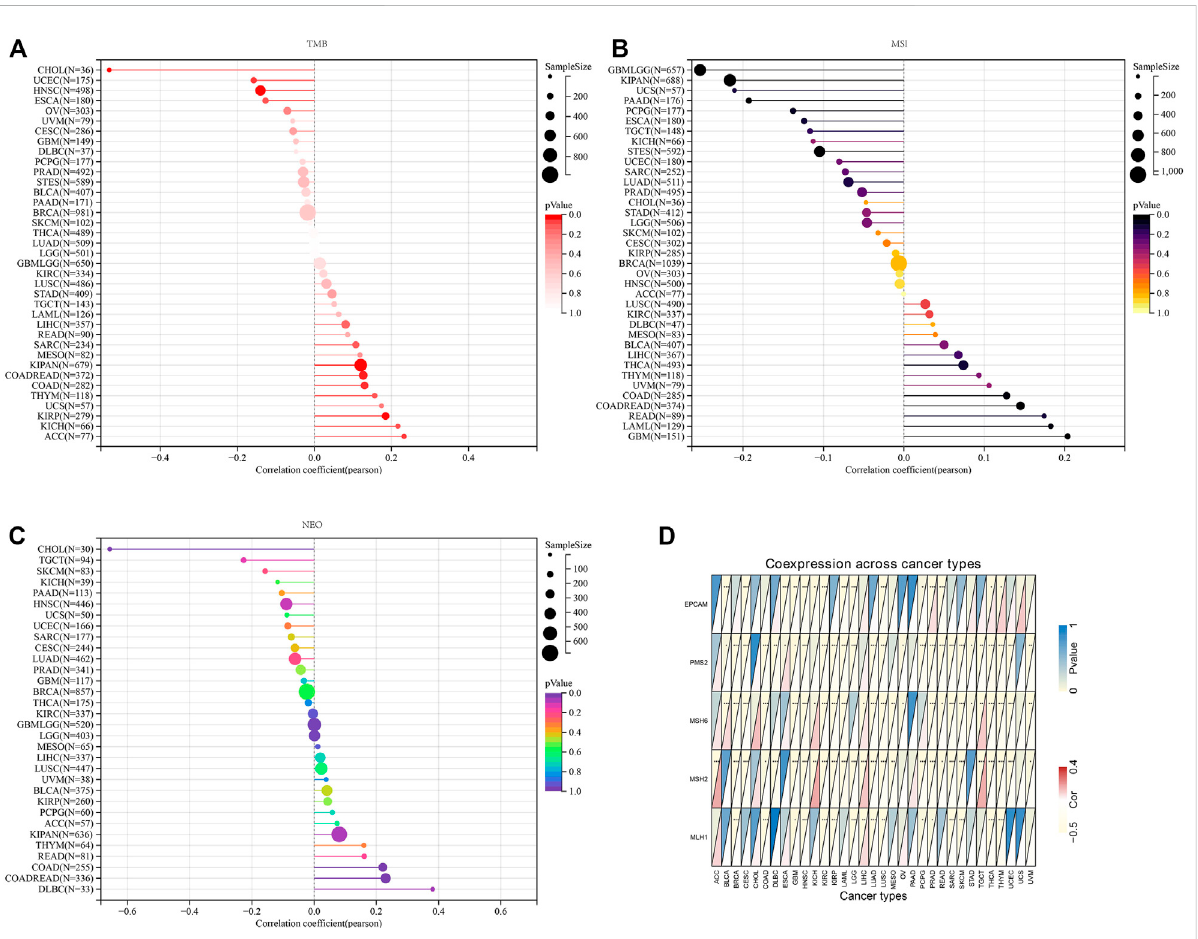
FIGURE 13 AnalysisofrelationshipbetweentheexpressionofAGTRAPandnovel biomarkersinordertopredictimmunotherapyresponses. (A) Correlation between the expression of AGTRAP and tumor mutation burden (TMB). (B) Correlation between the expression of AGTRAP and microsatellite instability (MSI). (C) Correlation between the expression of AGTRAP and neoantigen. (D) Correlation between the expression of AGTRAP and fi